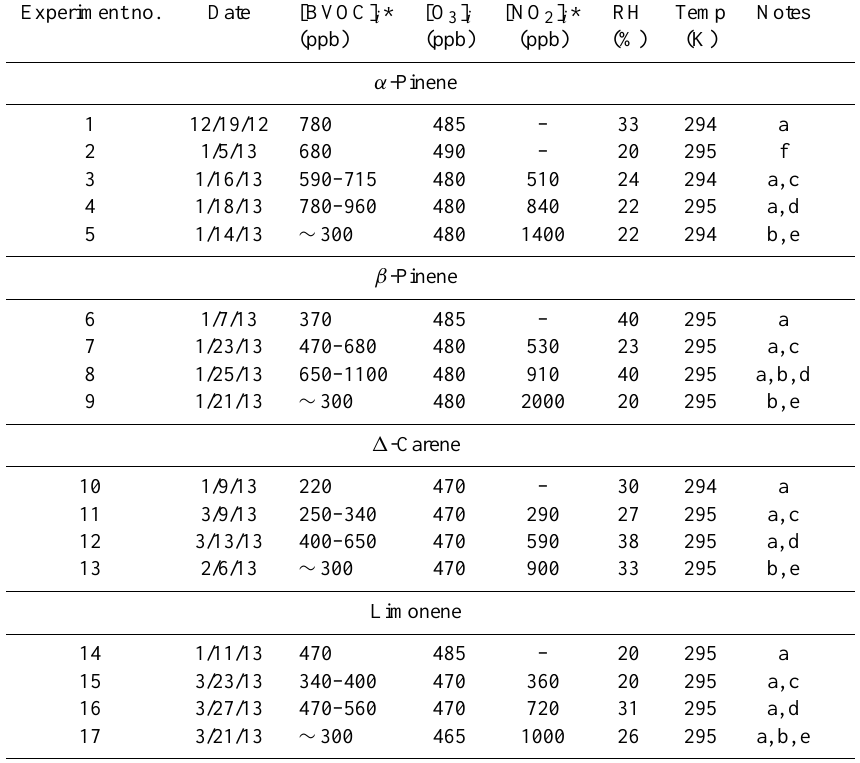
Table 2. Conditions for each chamber experiment. Experiment